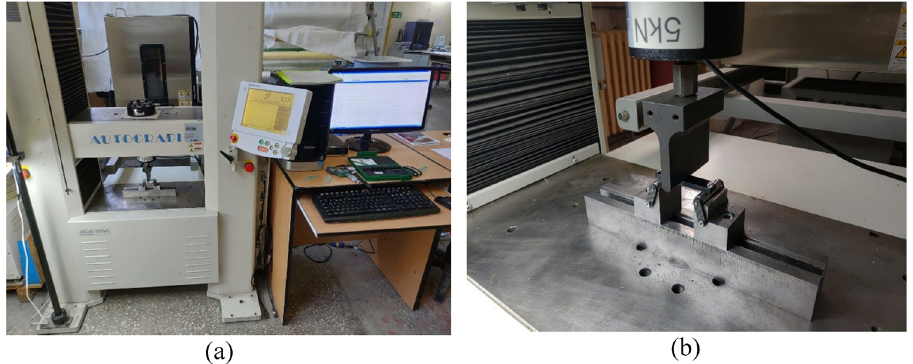
Figure 4: Image of bending tester: ( a ) fl exural strength tester and ( b ) fl exural strength